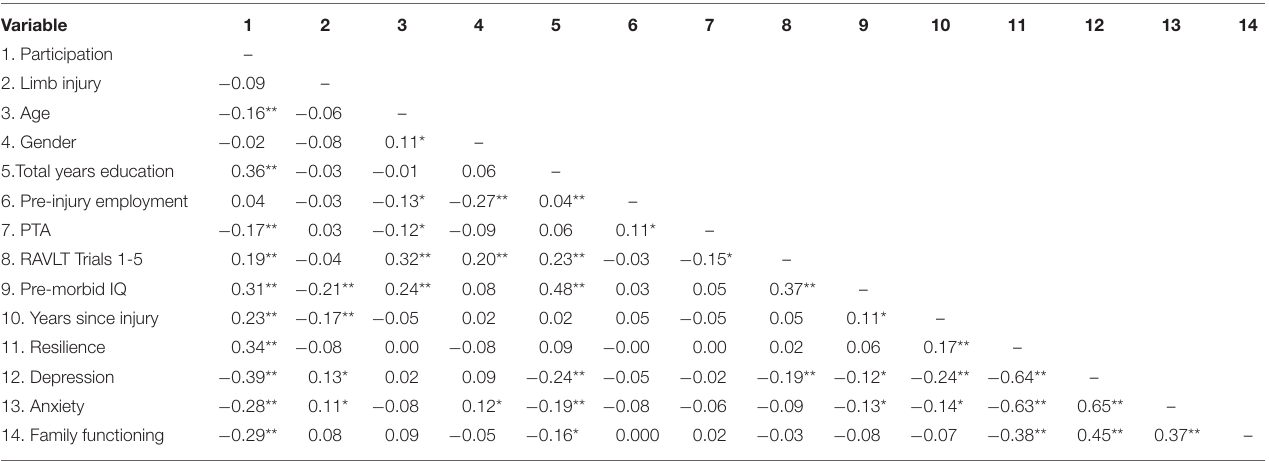
TABLE 3 | Correlations between demographic, injury, cognitive, personal, and participation variables.